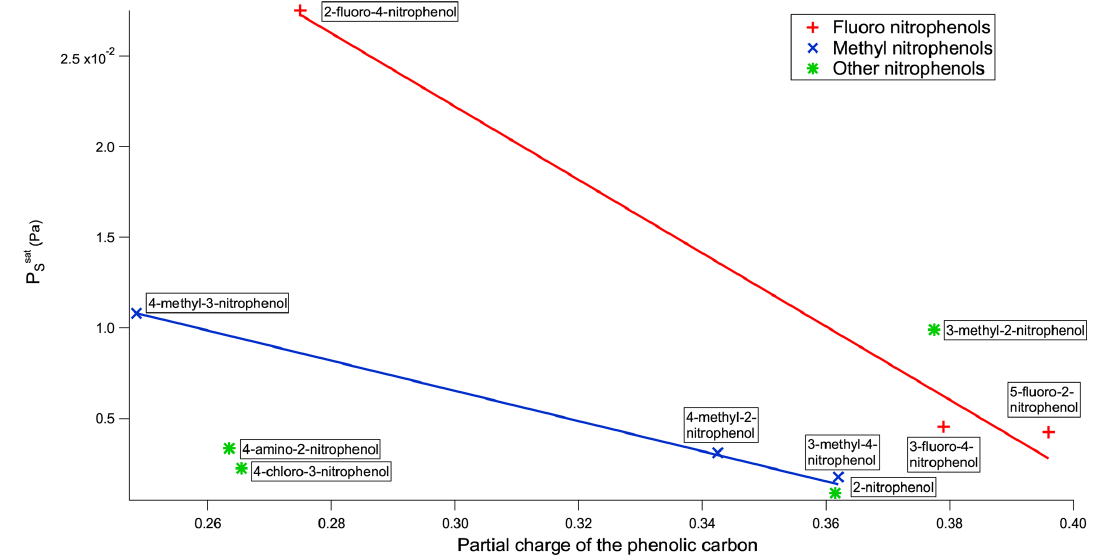
Figure 5. P sat vs. partial charge of the phenolic carbon of the nitrophenols. S